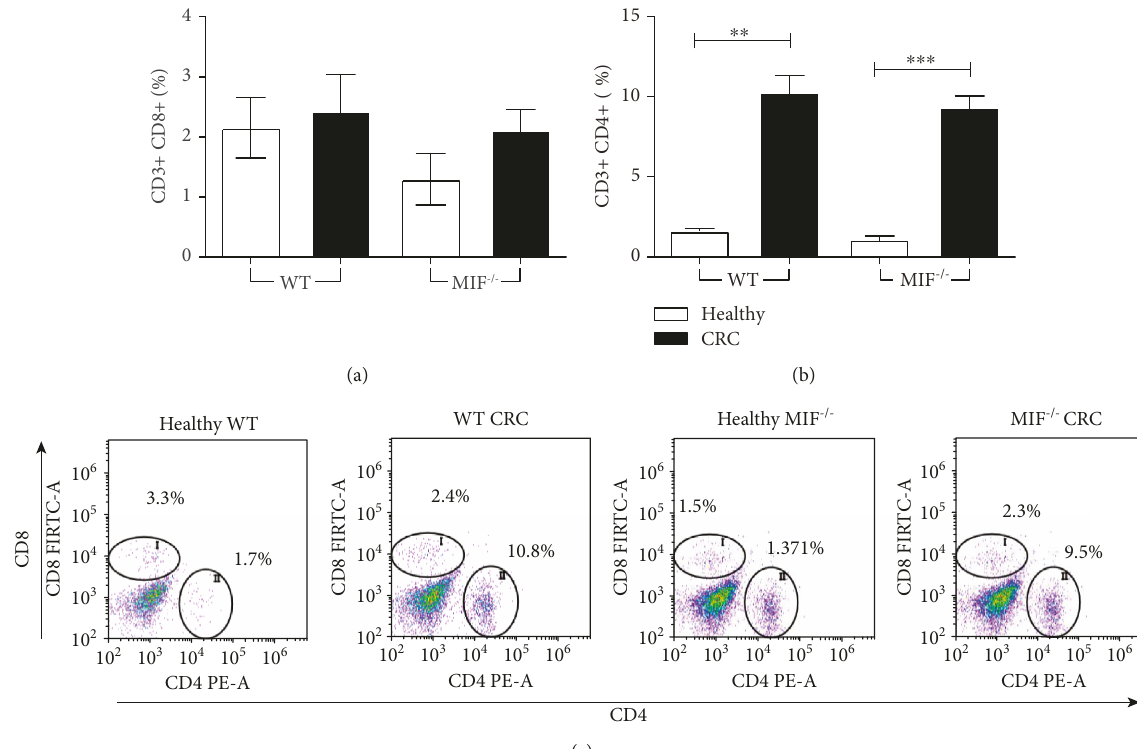
Figure 6: The T cell percentage is not a ff ected by the absence of MIF absence. (a) CD8+ vs. (b) CD4+ T cell percentage and (c) representative dot plots of T cell staining in the lamina propria from the colon of a mouse with colorectal cancer. Data are representative of three independent experiments and are plotted as the means ( ± SEM), n = 3 mice per group; ∗ p < 0 05 , ∗∗ p < 0 01 , and ∗∗∗ p < 0 001